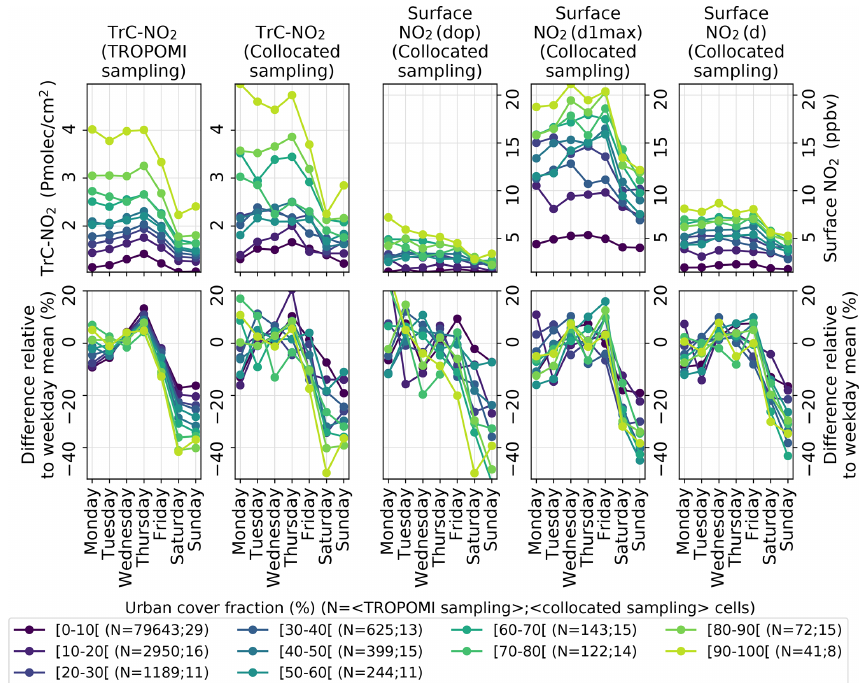
Figure G4. Mean weekly profiles (top panels) and differences relative to weekday (Monday–Friday) mean (bottom panels) during the first strict COVID-19 lockdown (15 March–31 May 2020) for different levels of urban cover fraction, considering (from left to right panels) the TROPOMI TrC-NO 2 full dataset, TROPOMI TrC-NO 2 collocated with surface stations, surface NO 2 mixing ratios collocated with TROPOMI at daily TROPOMI-overpass-time (dop), and daily 1h maximum (d1max) and daily 24h mean (d) timescales. The collocation of TROPOMI-based and surface-based observations is here performed both spatially and temporally (on a daily basis); the corresponding numbers of cells (averaged over the different days of the week) are indicated in the legend. Urban cover fractions are here binned in bins of